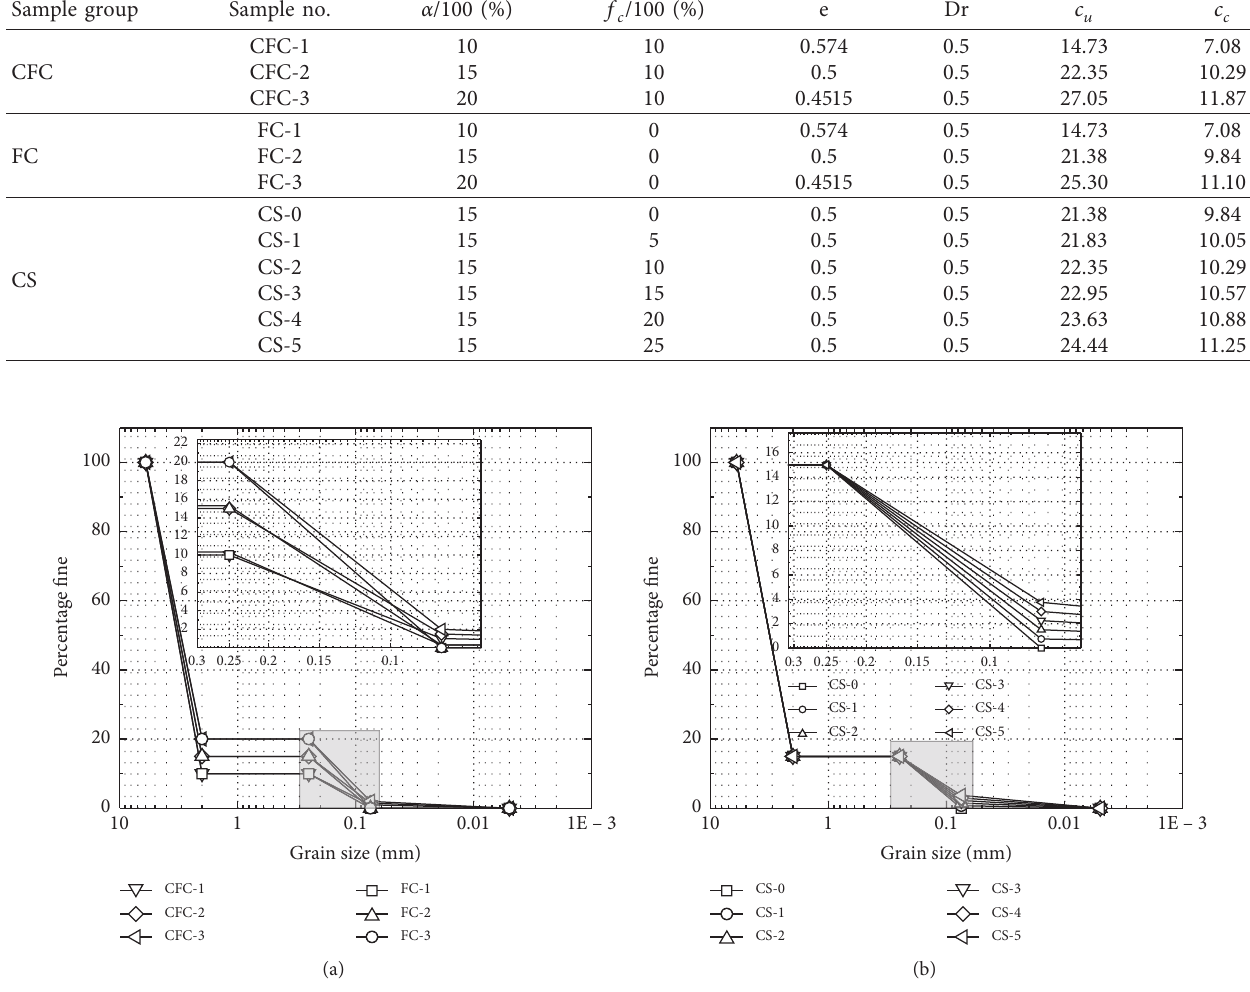
Figure 1: Grain size distribution curve. (a) Grain size distribution curve for CFC and FC groups. (b) Grain size distribution curve for CSC